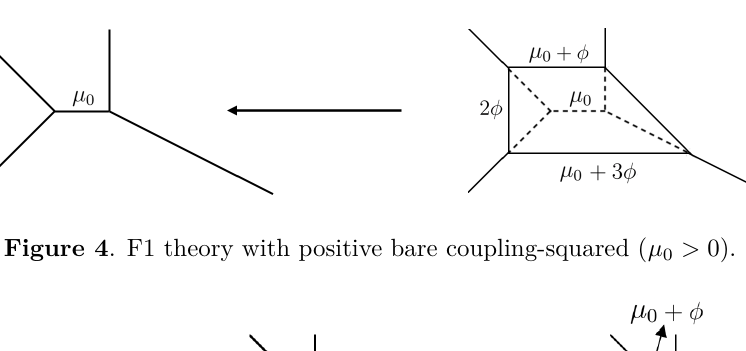
Figure 3 . F1 case, Brane web for 5d pure Sp(1) gauge theory with θ = π .